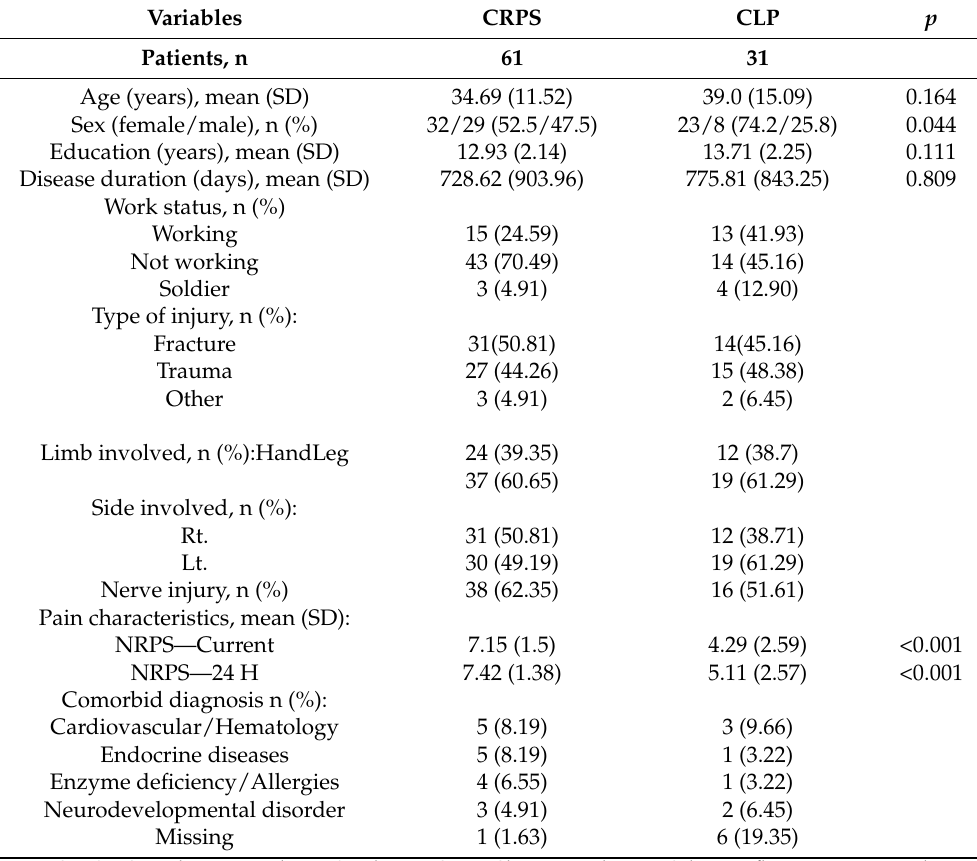
Table 1. Demographic data in CRPS and CLP